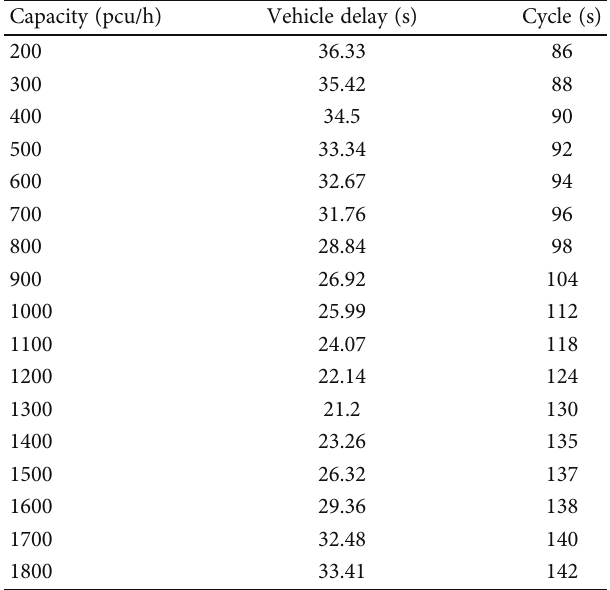
Table 11: The impact of capacity on vehicle average delay and signal cycle.